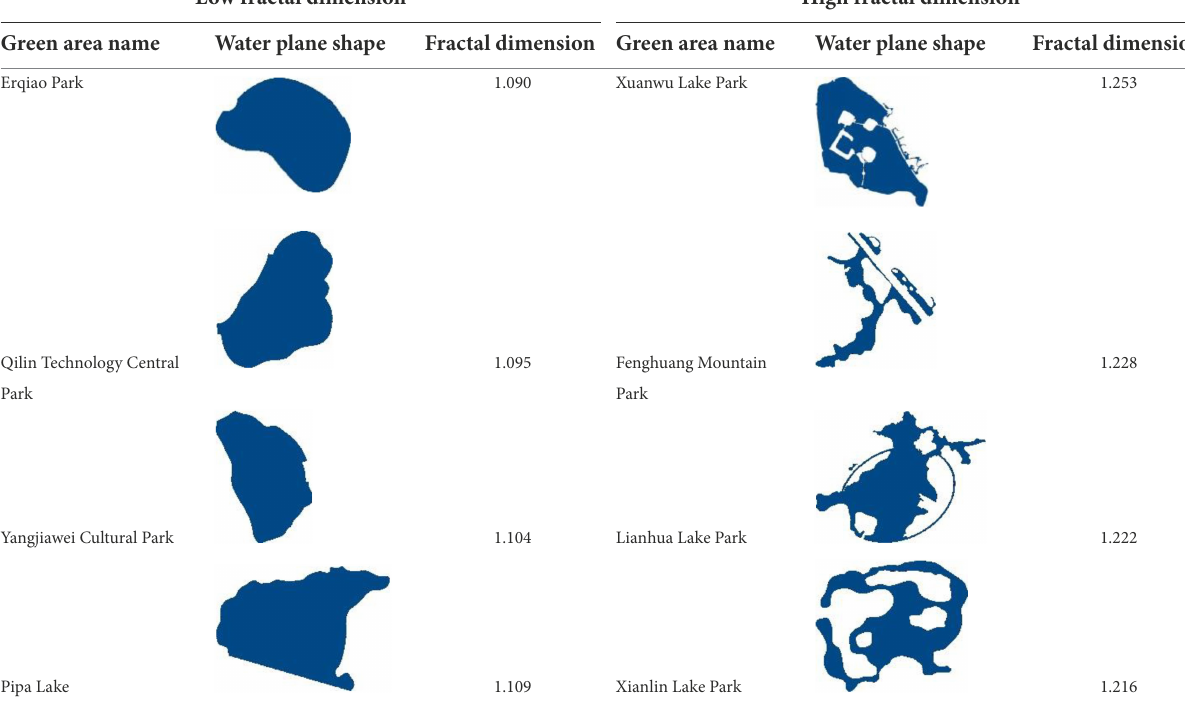
TABLE 9 Analysis of plane shapes of lower and higher water bodies with fractal